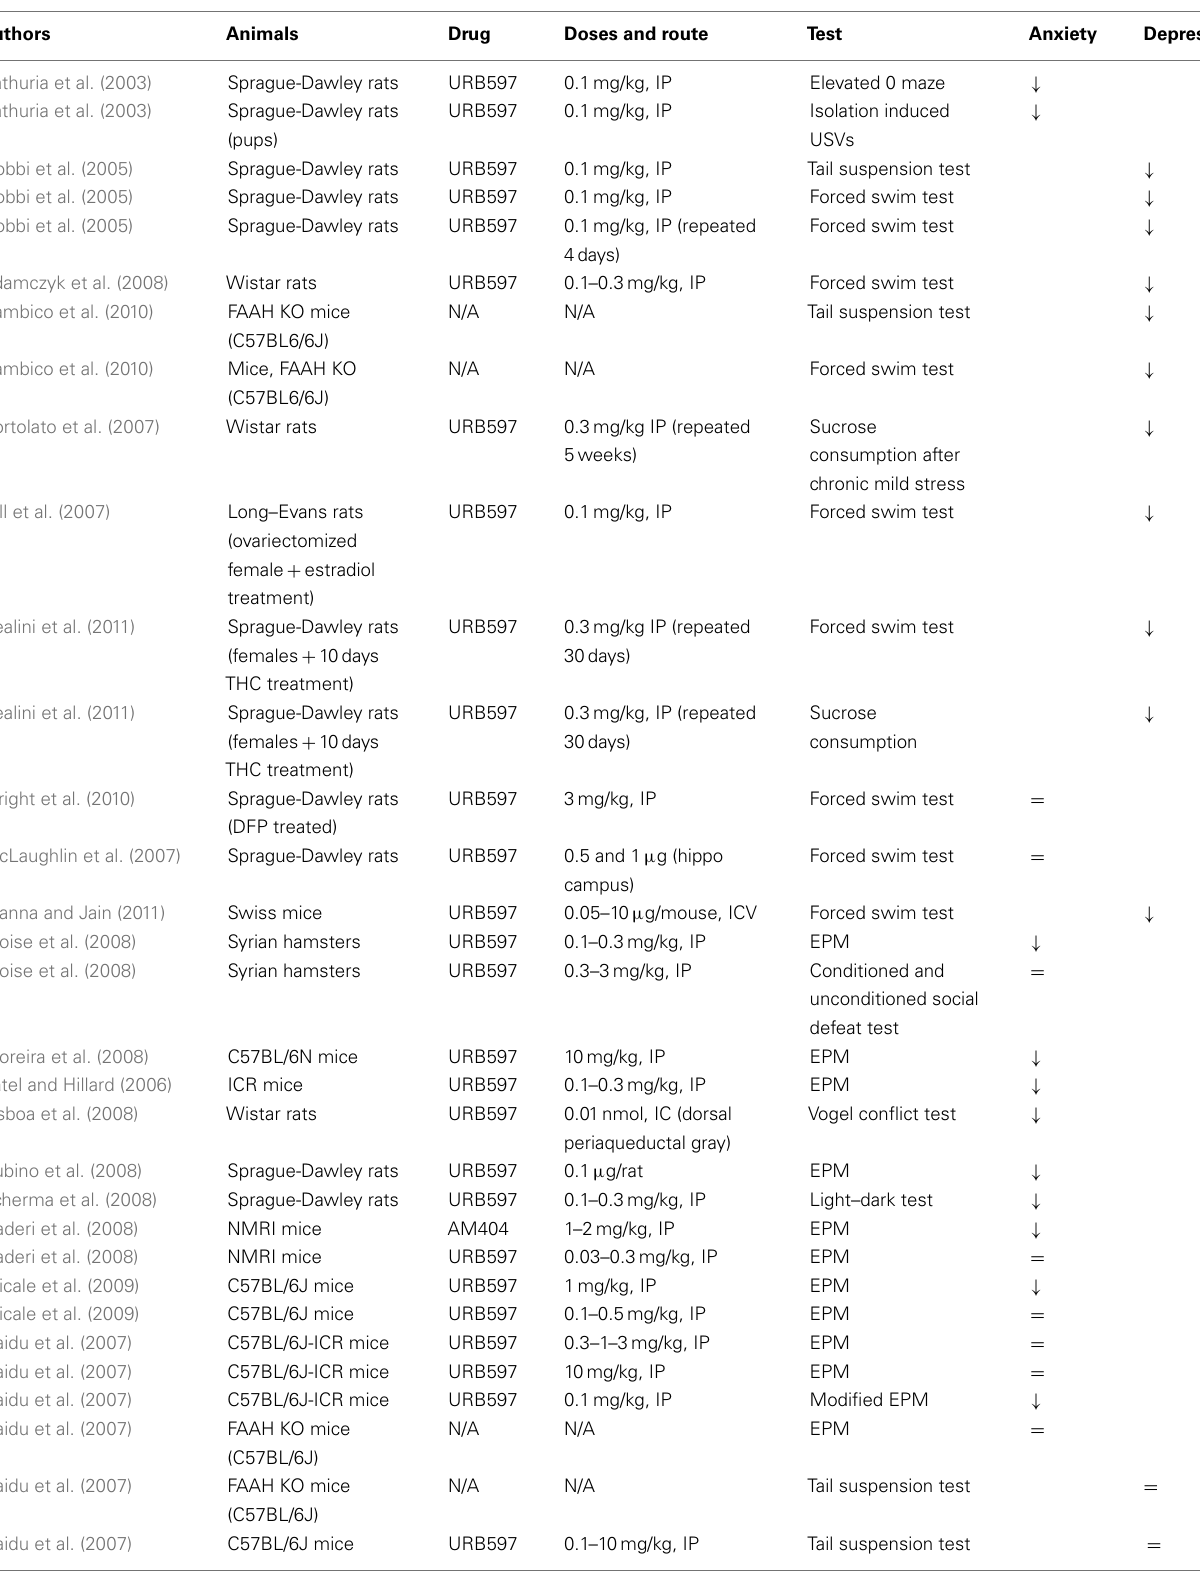
Table 3 | Summary of studies investigating the effects of the FAAH inhibitor URB597 or genetic deletion of FAAH on anxiety-like and depression-like behavior in